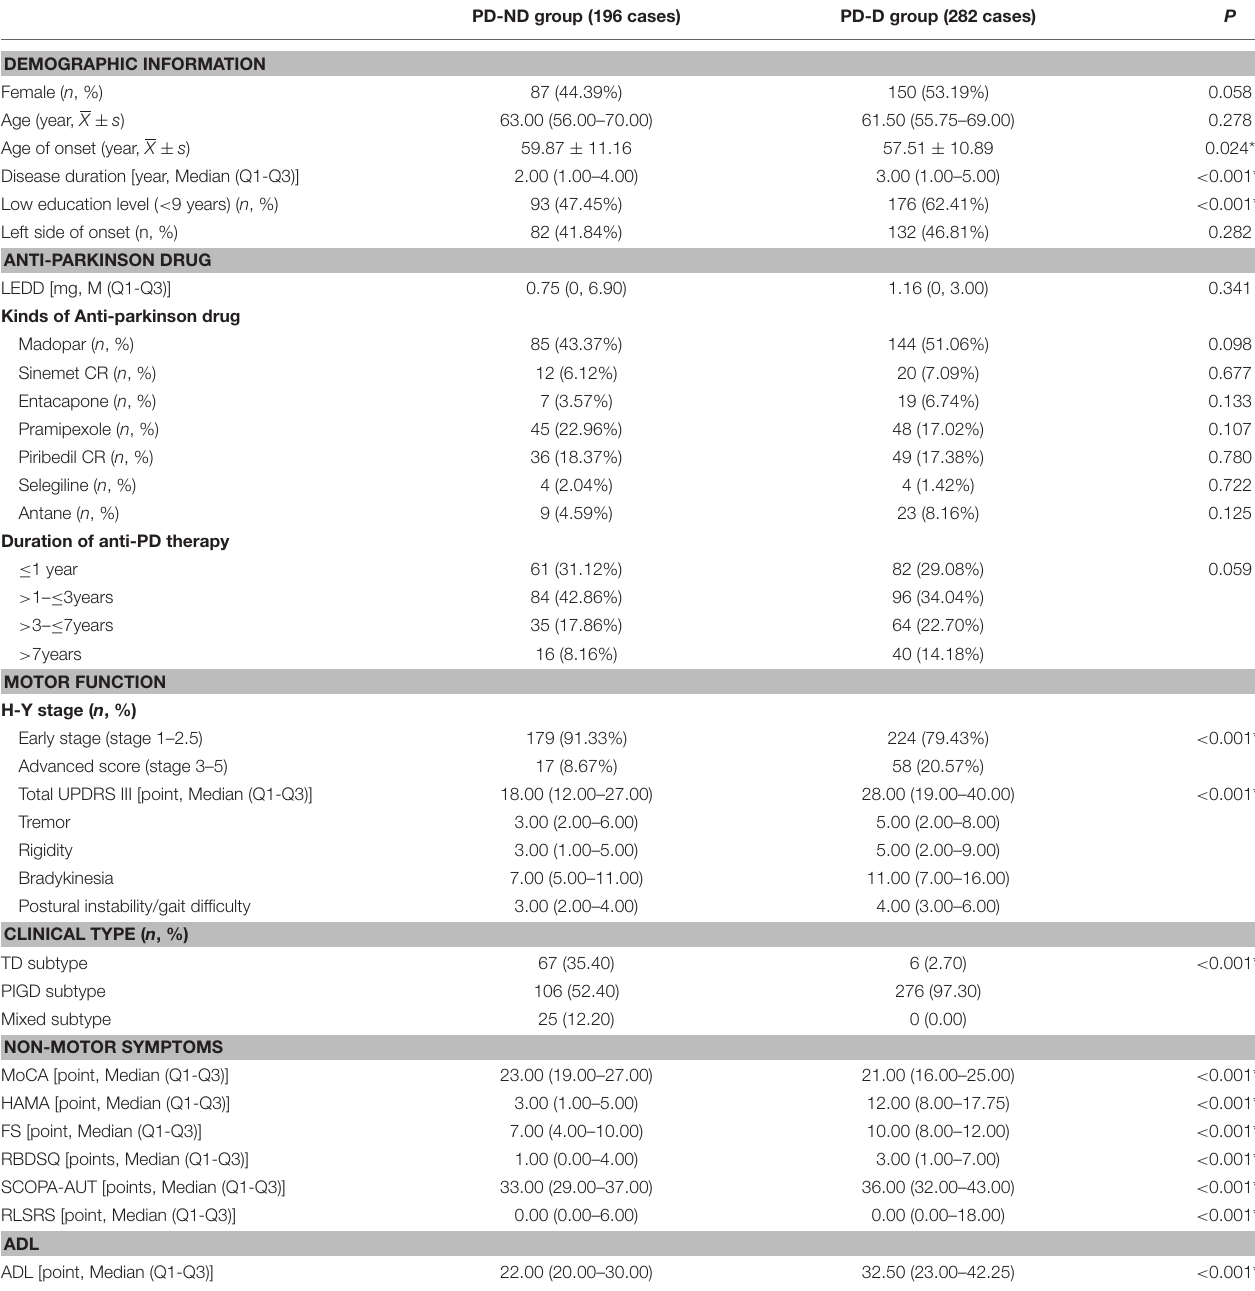
TABLE 2 | Demographic variables, motor function, non-motor symptoms, and ADL of PD-D and PD-ND